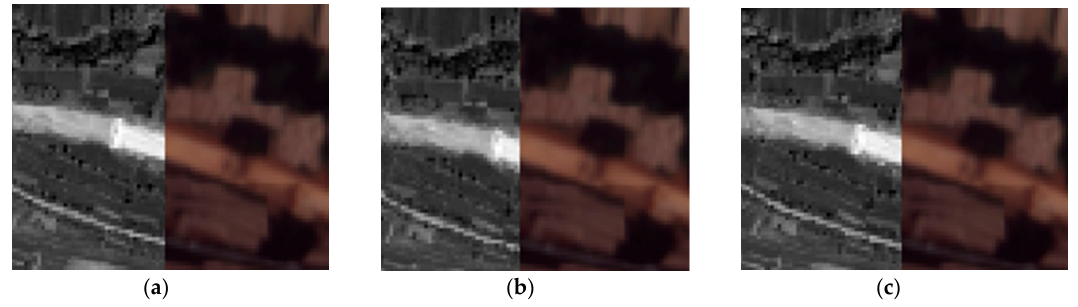
Figure 15. Local Registration result on Dataset 3. ( a ) Registration result by Lee’s method. ( b ) Registration result by Li’s method. ( c ) Registration result by the proposed method.